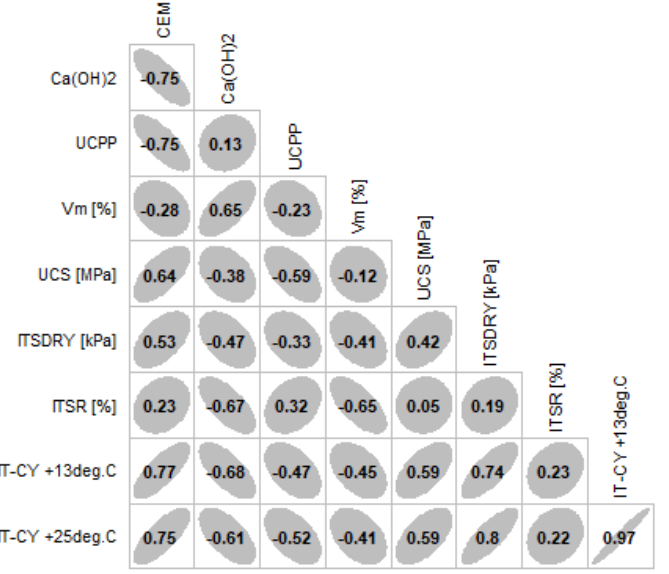
Figure 6. Correlation between selected CRM-FB layer and amount of innovative binder constituents.